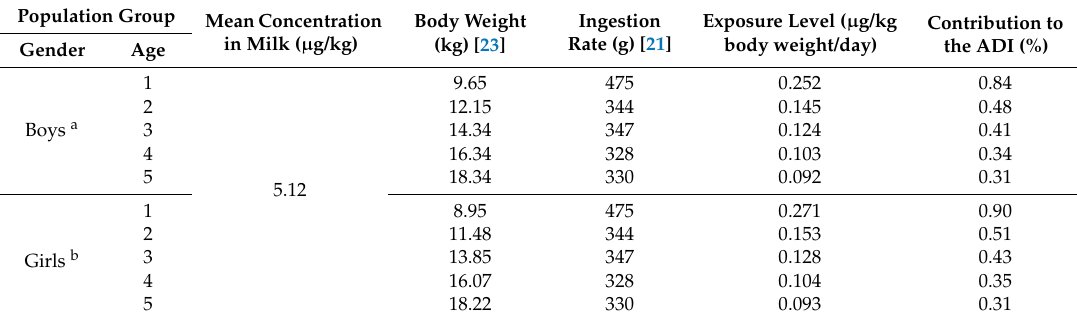
Table 5. Estimated dietary exposure of children aged between one and five years old to progesterone in raw milk, using the mean concentration.